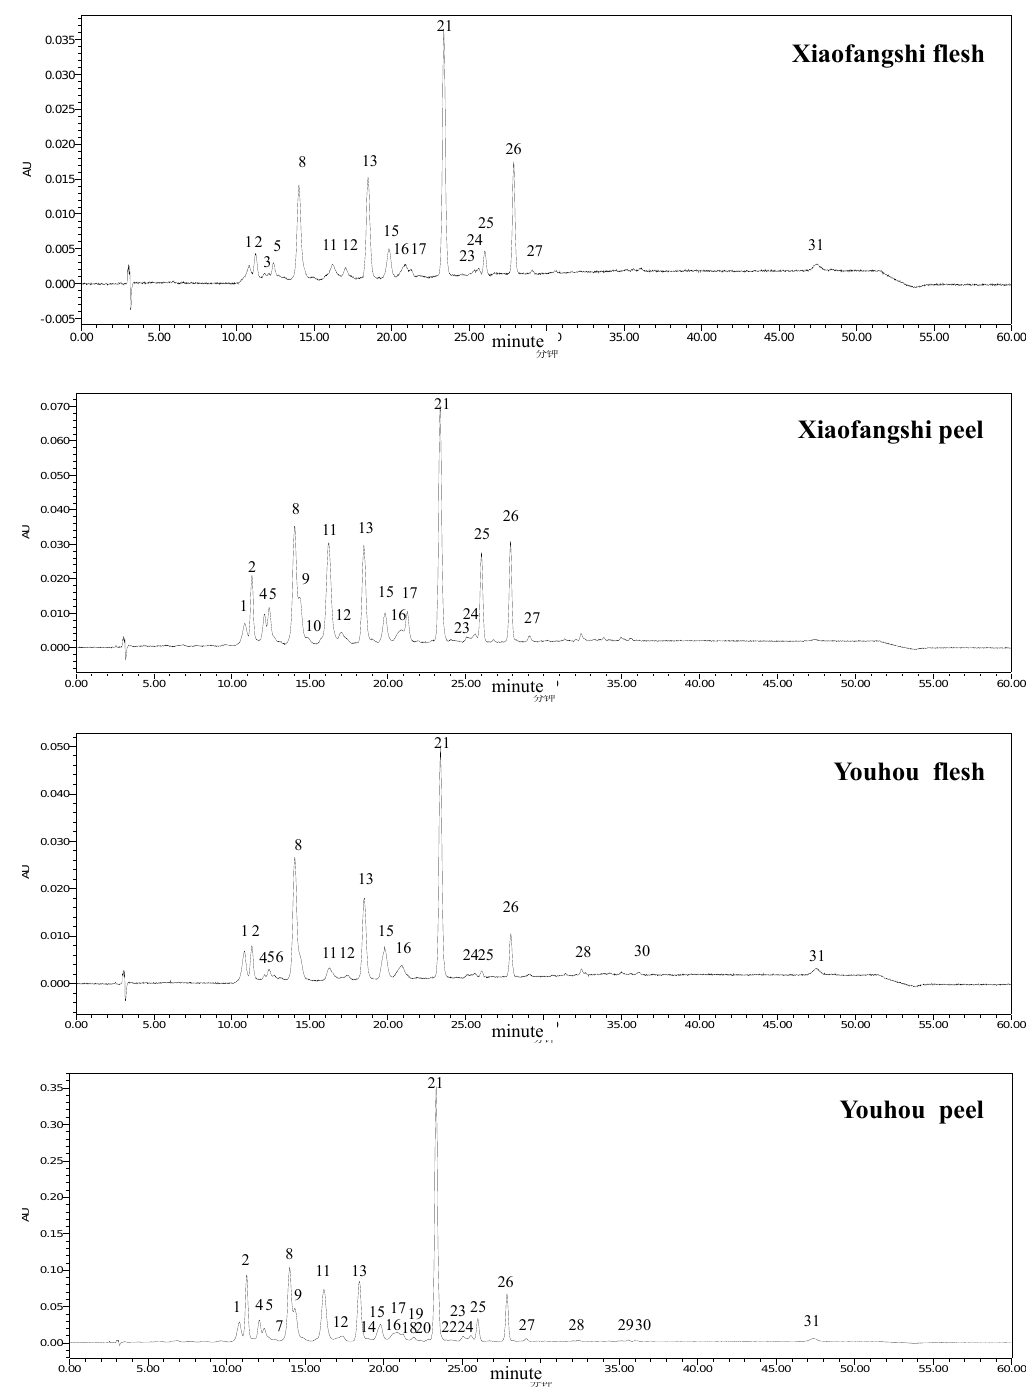
Figure 1. HPLC chromatograms of the extraction of the saponified carotenoids in the peel and the flesh of persimmon cv. ‘Xiaofangshi’ and ‘Youhou’, monitored at 450 nm. The peaks were numbered according to the elution sequence, see Table 2 for